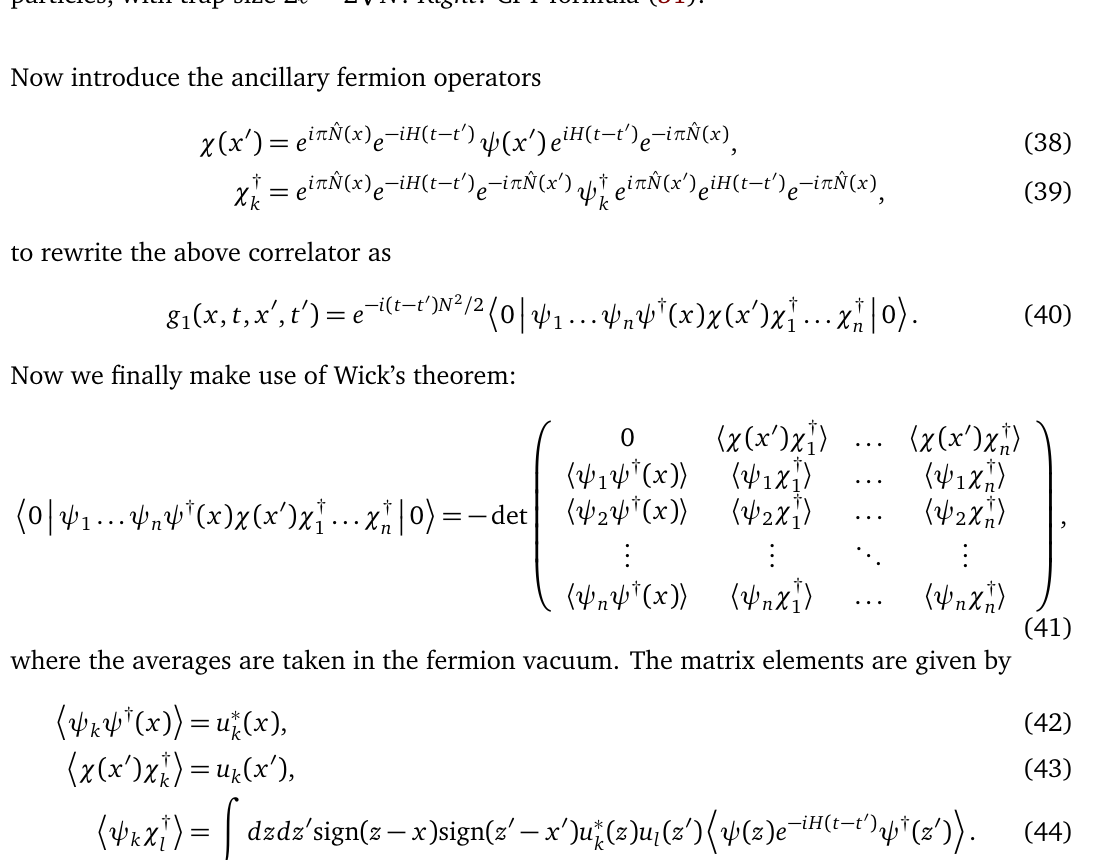
Figure 2: Density plot of g particles, with trap size 2 (cid:96) = 2